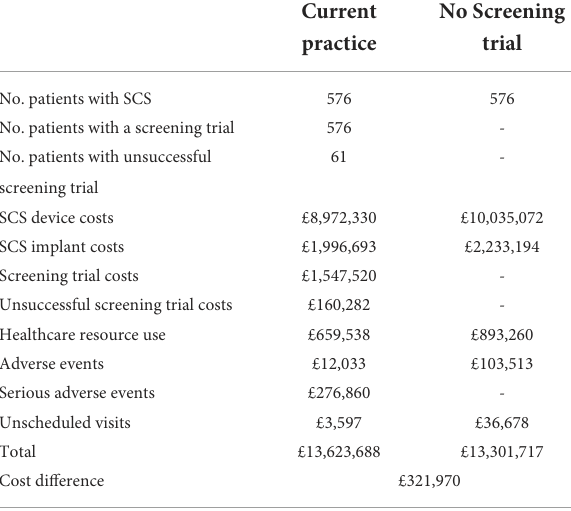
TABLE 5 Difference in current practice and a no screening trial strategy for the year 2019/20 including resource use incurred in the first year of